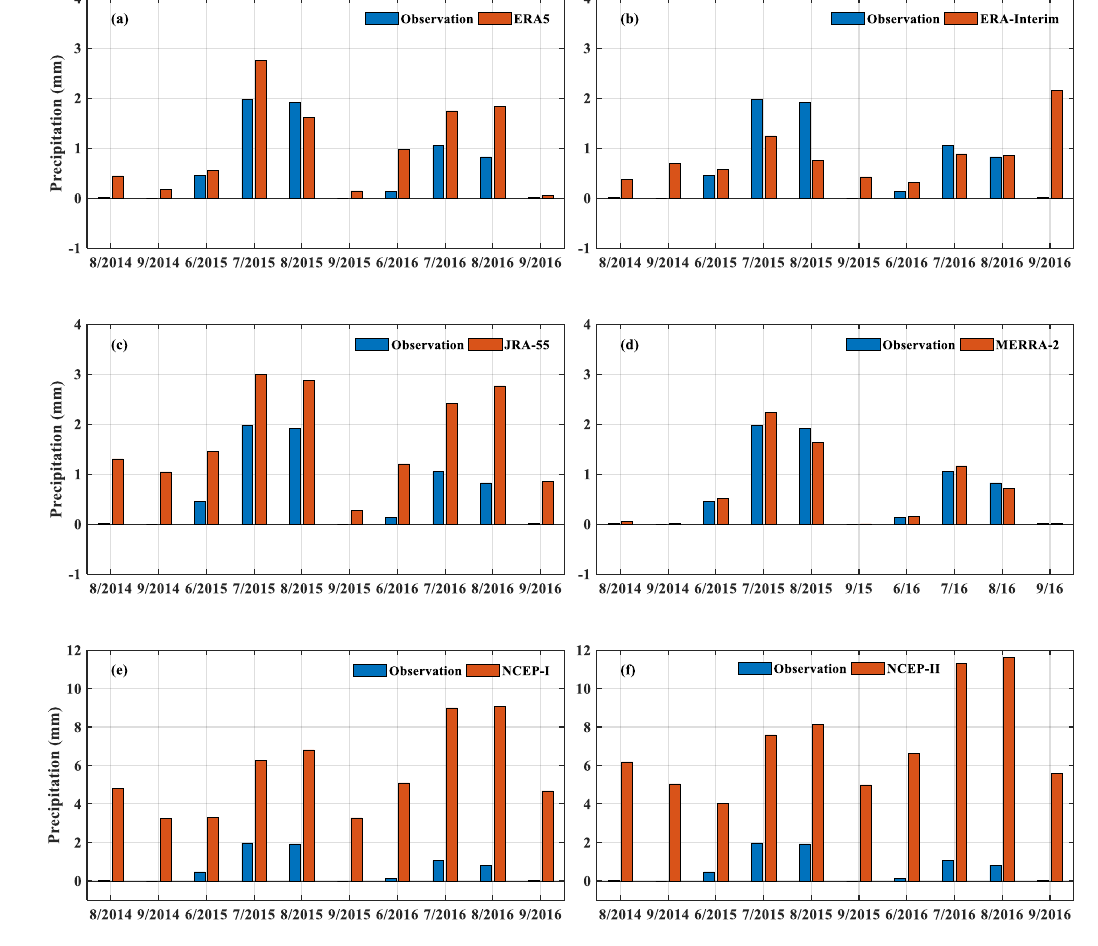
Figure 5. The observed and reanalysis monthly precipitation values in summers at the Ali site from 2014 to 2016.